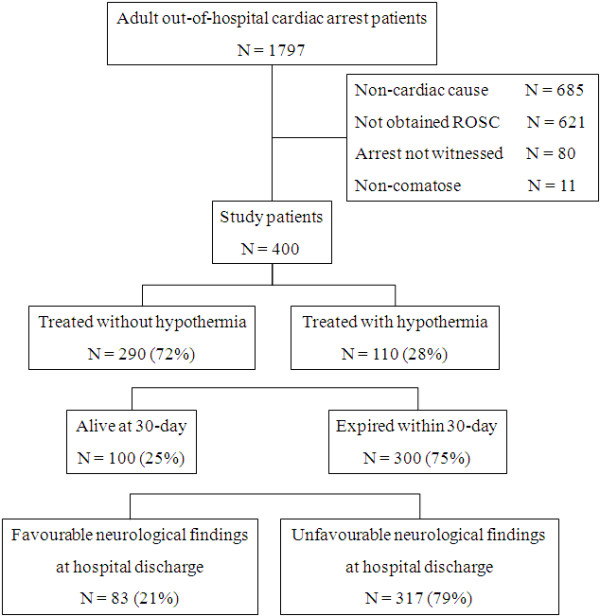
Flow diagram of study patients and outcomes. ROSC, return of spontaneous circulation.